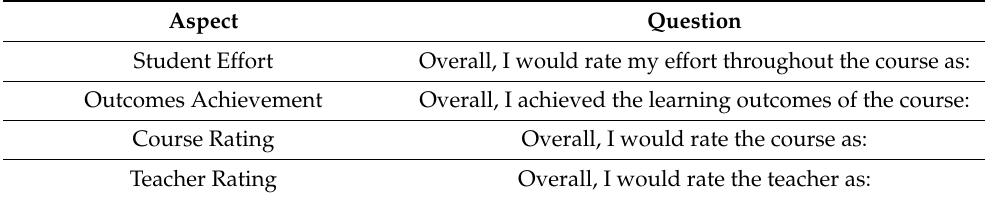
Table 1. The key aspect and mapping question in SFQ.